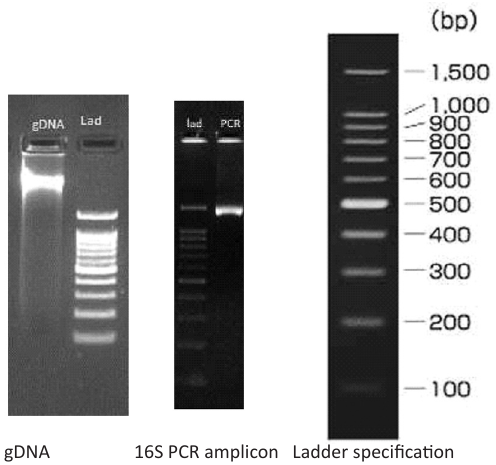
Fig. 2. gDNA and 16S Amplicon QC data